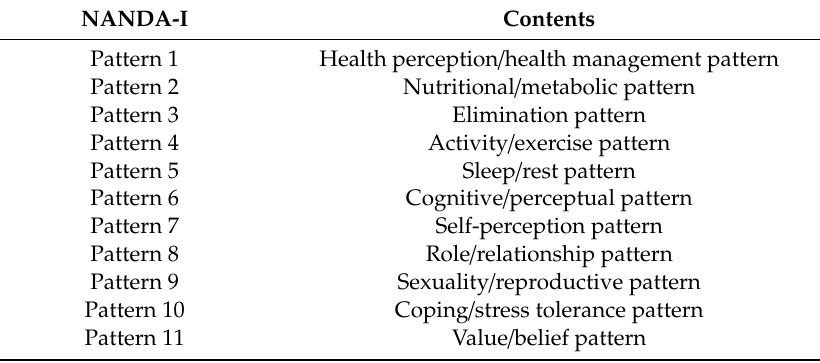
Table 2. The North American Nursing Diagnosis Association (NANDA)